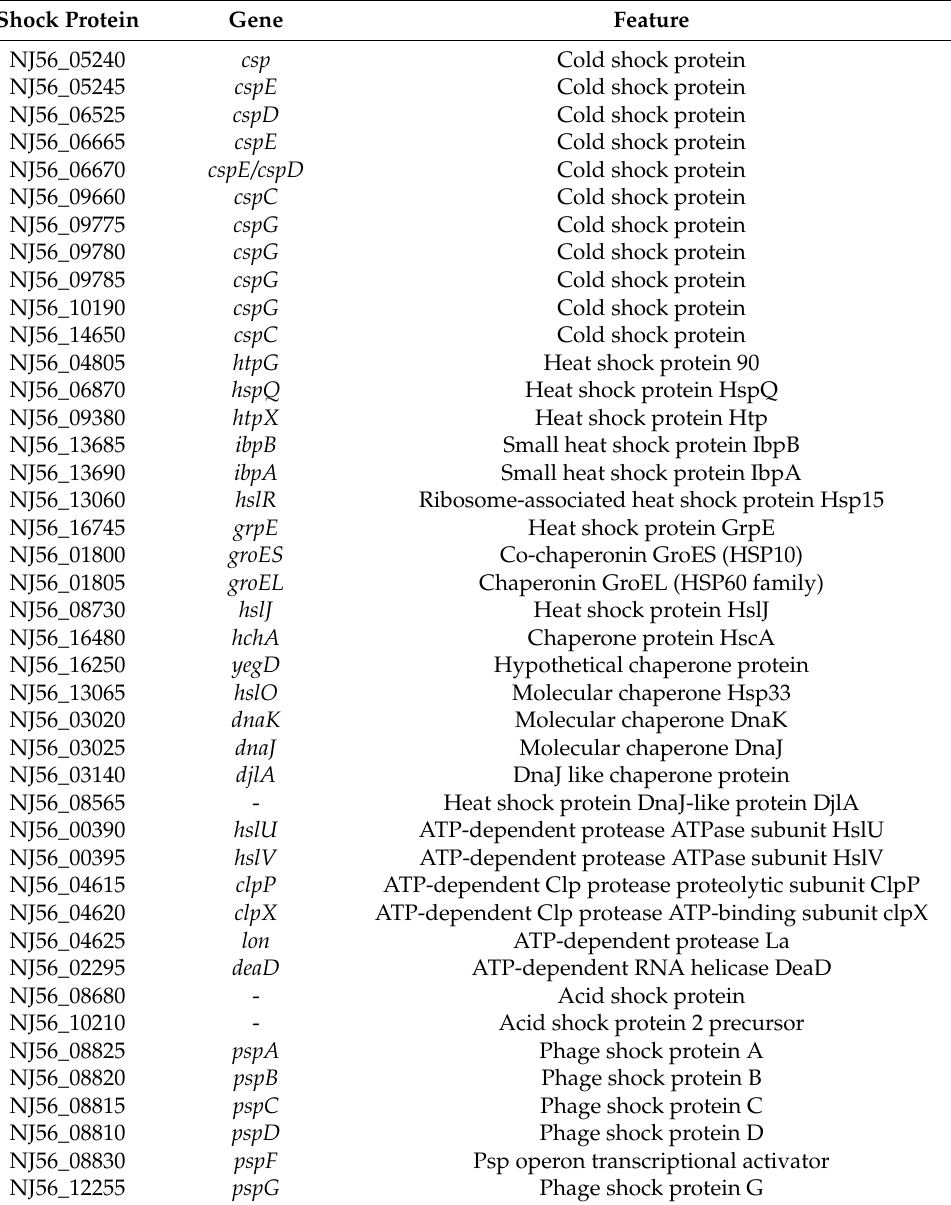
Table 5. Shock proteins in Y. ruckeri